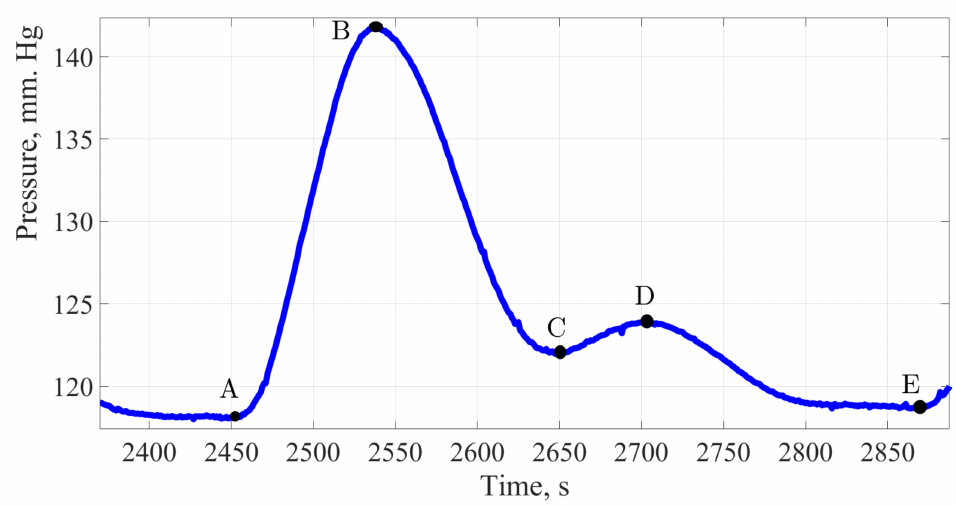
Figure 7. The pulse wave signal of a man 60 years of